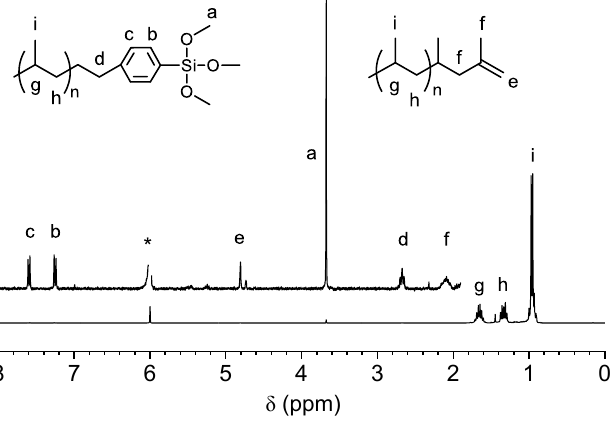
Figure1. 1 H-NMRspectrumofmethoxysilane-terminated i PP( i PParm). Solvent(*): 1,1,2,2-tetrachloroethane- Figure 1. 1 H-NMR spectrum of methoxysilane-terminated i PP ( i PP arm). Solvent (*): 1,1,2,2- d 2 . tetrachloroethane- d 2 .